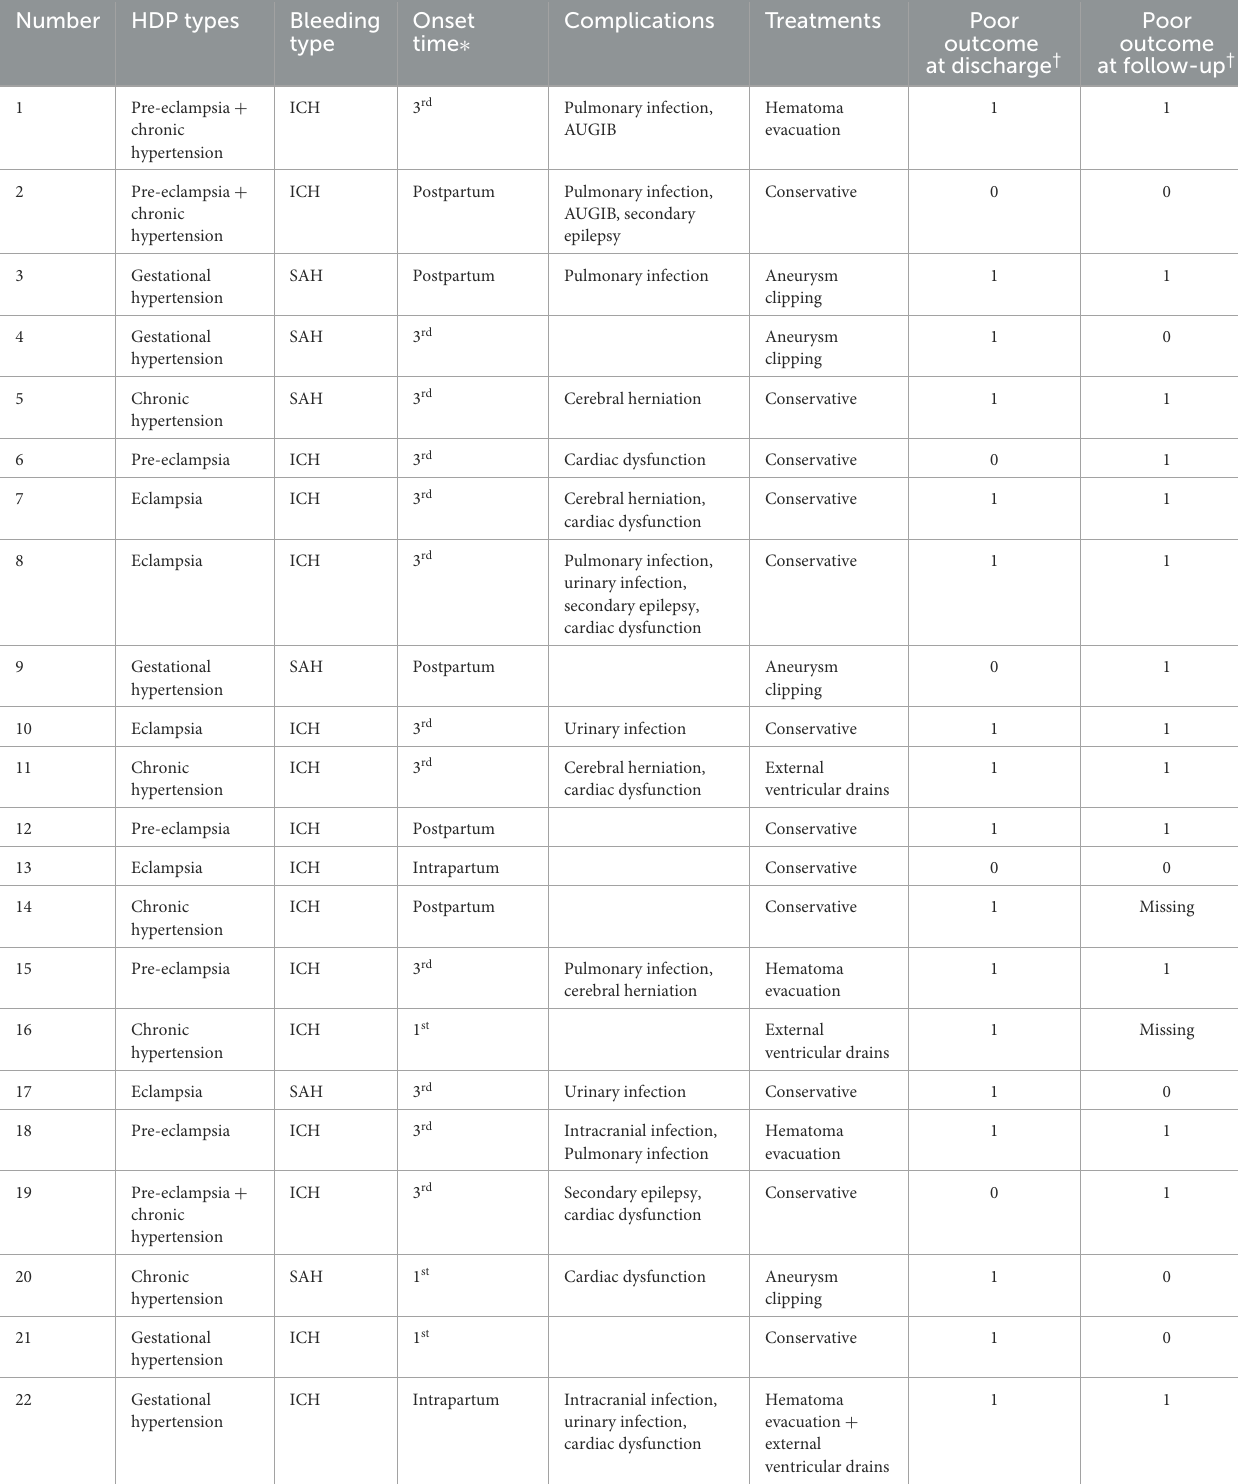
TABLE 2 Brief description of all patients in hypertensive disorders (HDP) of pregnancy group.